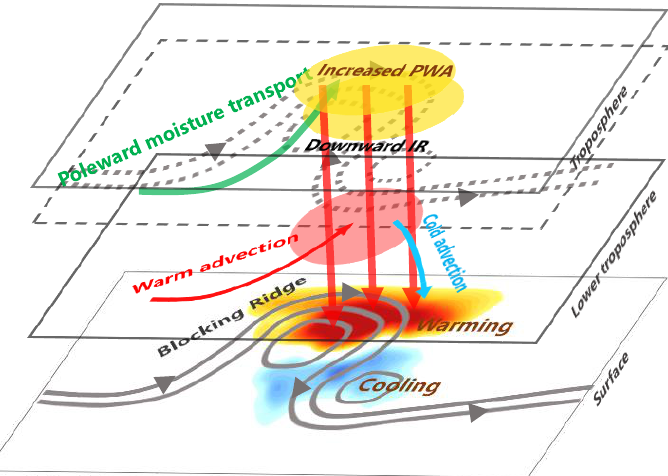
Figure 10. Schematic diagram of the physical process by which the blocking circulation affects the regional sea ice decline. At the surface (bottom layer), the red (blue) shading represents a positive (negative) SAT anomaly. The streamlines represent the blocking circulation, which is a deep system from the surface to the top of the troposphere. Other processes are indicated in the figure.